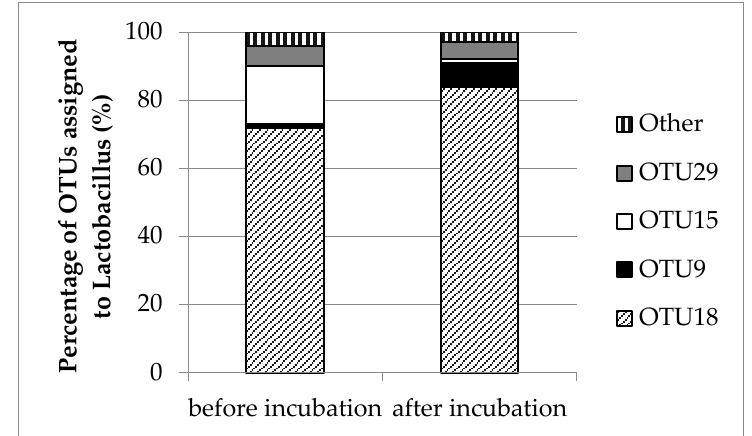
Figure 10. Percentage of sequences assigned to different OTUs in the total of Lactobacillus sequences in T1 mini-silos before and after incubation.